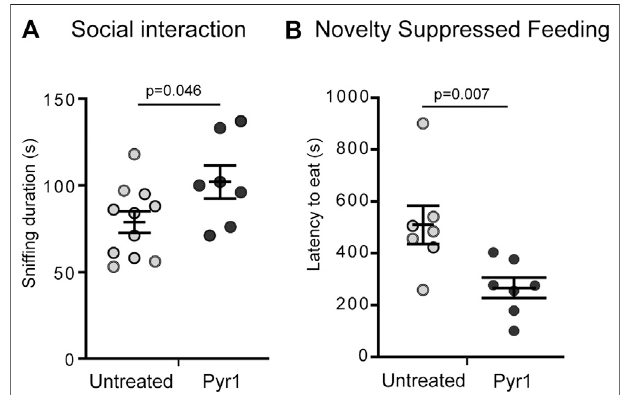
FIGURE 3 | Pyr1 treatment alleviates behavioral defects of MAP6 KO mice (A) Effect of Pyr1 on social behavior. Social interaction was assayed by measuringthetimeaMAP6KOresidentmalespentsnif fi nganintruder(78.8 ± 6.2 and 102.0 ± 9.6 for untreated and Pyr1-treated mice, respectively). Snif fi ng behavior was analyzed over a 5 min period. Values correspond to mean ± SEM.Mann-Whitneytest, p (cid:2) 0.046. n (cid:2) 11foruntreatedmiceand n (cid:2) 7 for Pyr1-treated mice (B) Effect of Pyr1 on depressive/anxiety status. Novelty Suppressed Feeding (NSF) test was used to measure the latency to eat (509.3 ± 73.6 and 266.4 ± 39.7 for untreated and Pyr1-treated mice, respectively). Values correspond to mean ± SEM. Mann-Whitney test, p value is indicated. n (cid:2) 7 for untreated and Pyr1-treated